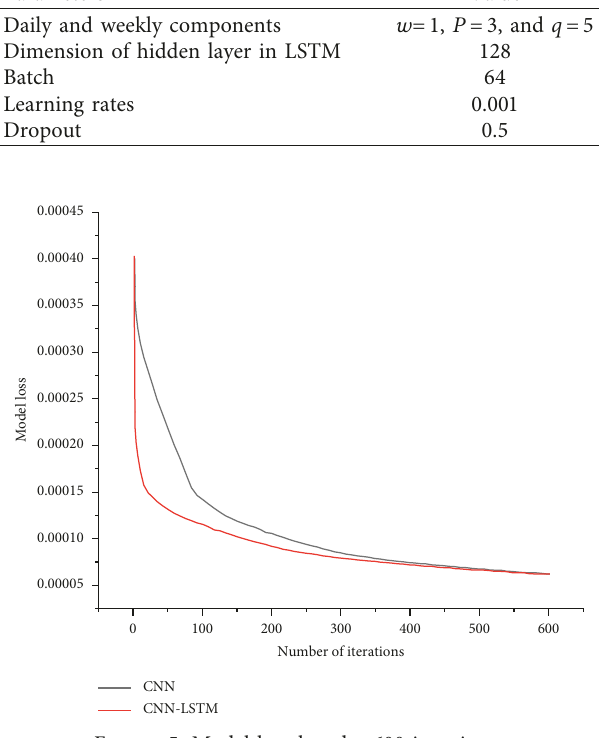
Figure 5: Model loss l under 600 iterations.